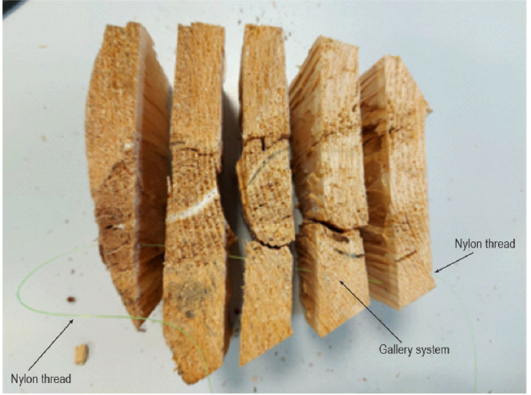
Figure 1. Nylon thread pulled through T. oxyurus gallery system.